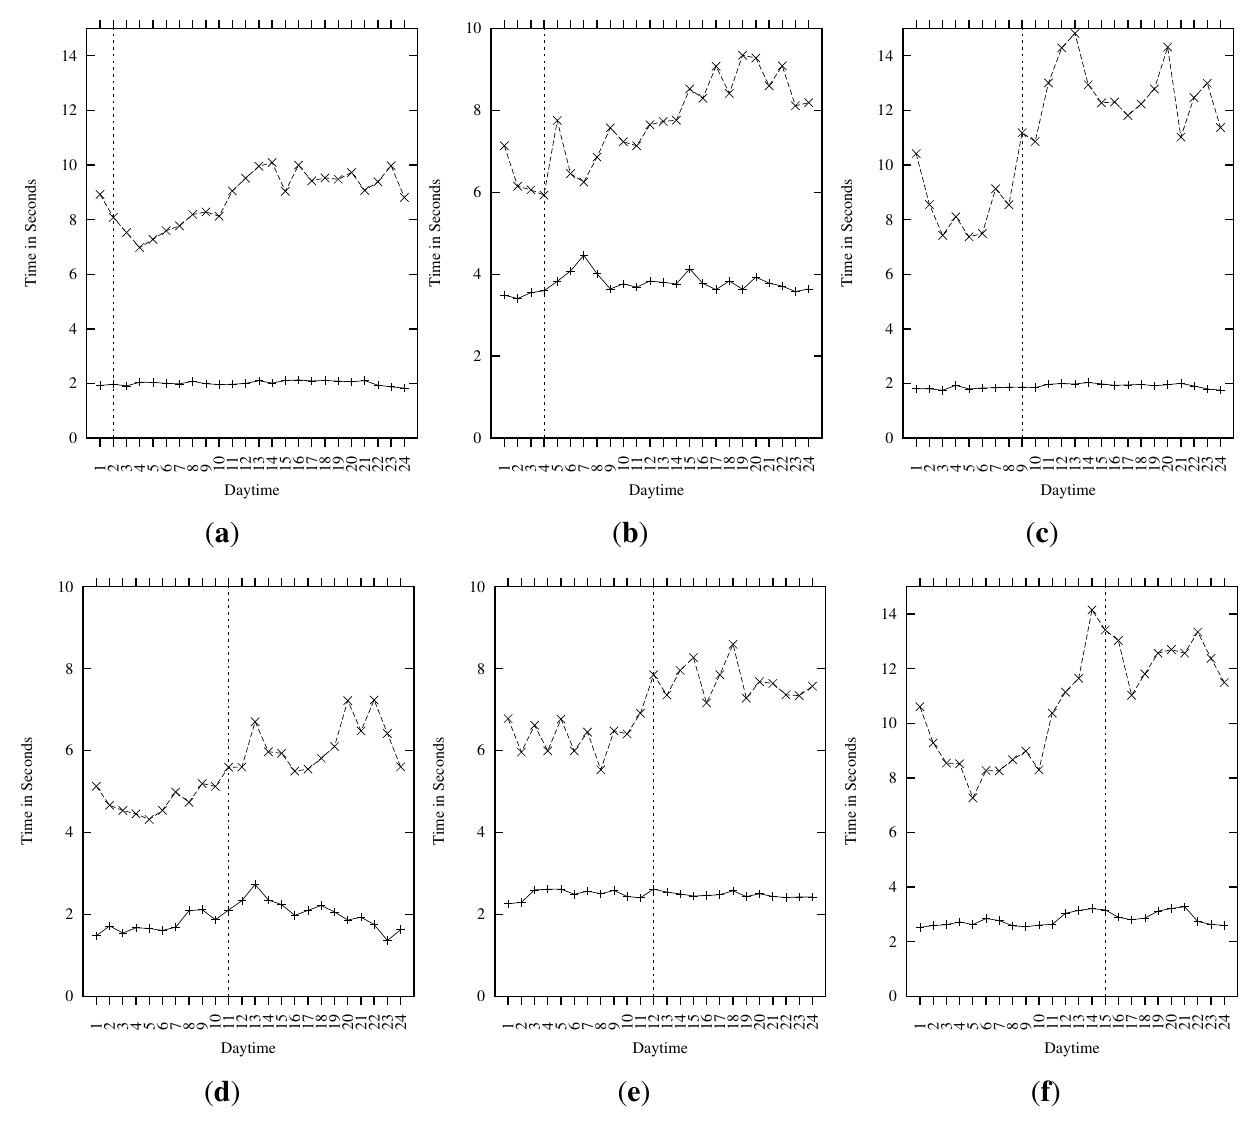
Figure 8. GMT Daytime Comparison (Core Latency; + : Direct, x : via Tor). ( a )